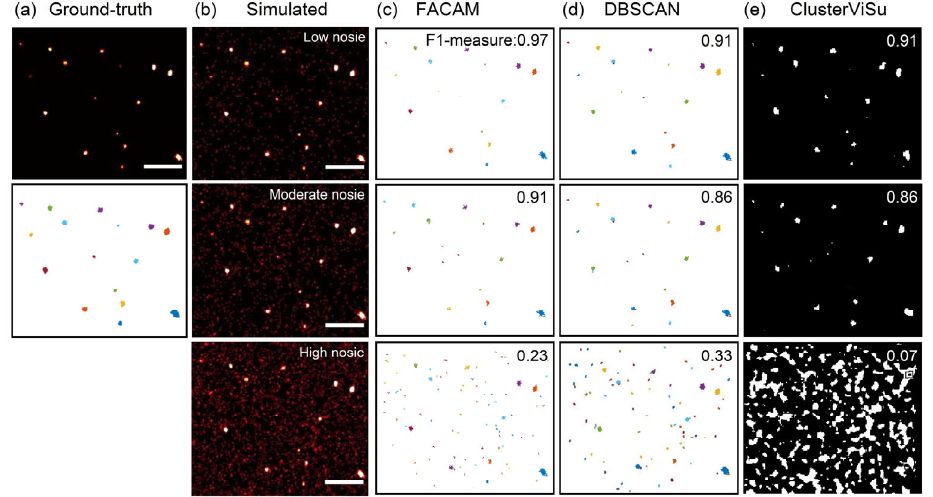
Figure 3. The clustering performance of FACAM, DBSCAN, and ClusterViSu on the simulated dataset. ( a ) Ground-truth (top) and its dotted image (bottom). ( b ) Reconstructed super-resolution images of the simulated datasets containing different levels of noise. The noise levels in ( b ): (top) low noise, (middle) moderate noise, (bottom) high noise. ( c ) The clustering results from FACAM for the simulated datasets in ( b ). ( d ) The clustering results from DBSCAN for the simulation datasets in ( b ). ( e ) The clustering results from ClusterViSu for the simulation datasets in ( b ). F1-measure values are also shown at the top-right corners of each figure in ( c – e ). Scale bar: 500 nm.